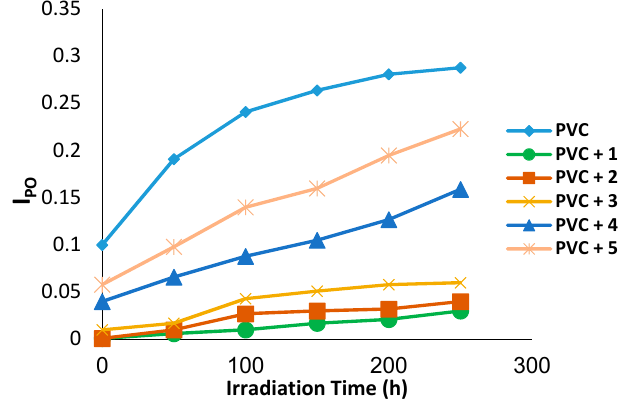
Figure 4. The relationship between the irradiation time (h) and polyene index ( I PO ) for PVC films (30 μ m thickness) with Schiff’s bases 1 – 5 (0.5% by weight) as additives.